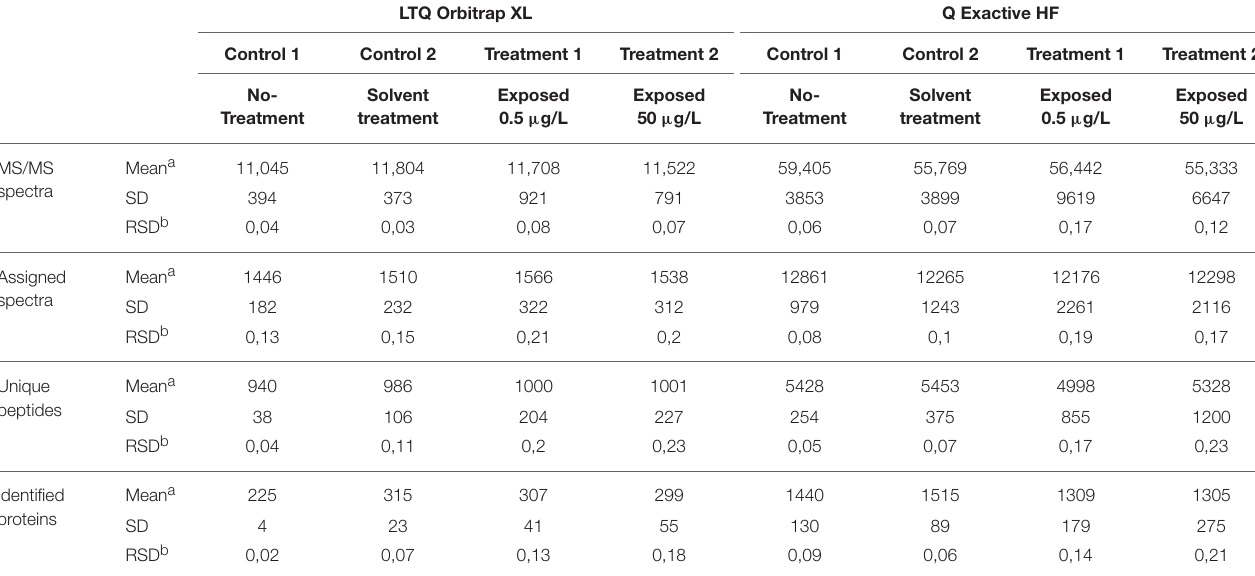
TABLE 1 | Summary and statistical characteristics of the two G. fossarum proteome